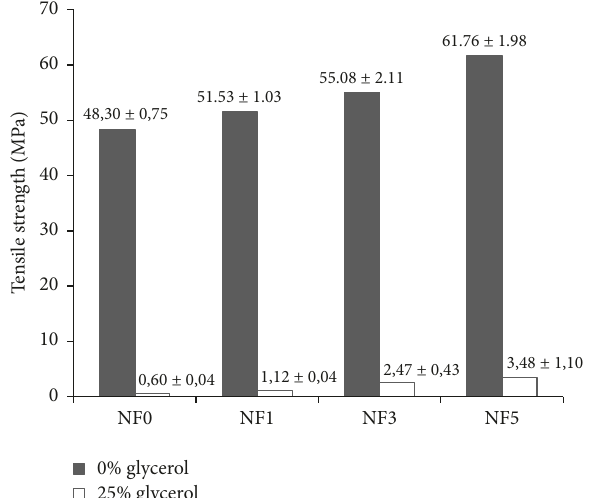
Figure 5: Elongation at break of TPS/PVA cellulose nanocomposite